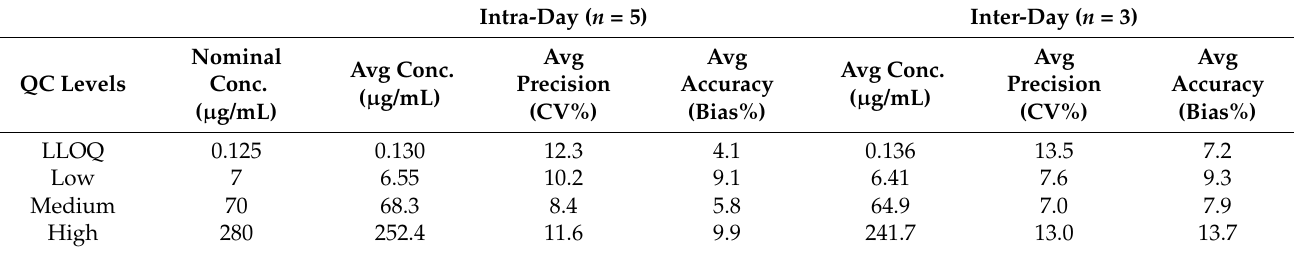
Table 3. Intra-day and inter-day average (avg) precision and accuracy assessed at four concentration levels (LLOQ, LQC, MQC and HQC) for five times (intra-day) in three different analytical runs (in- ter-day).